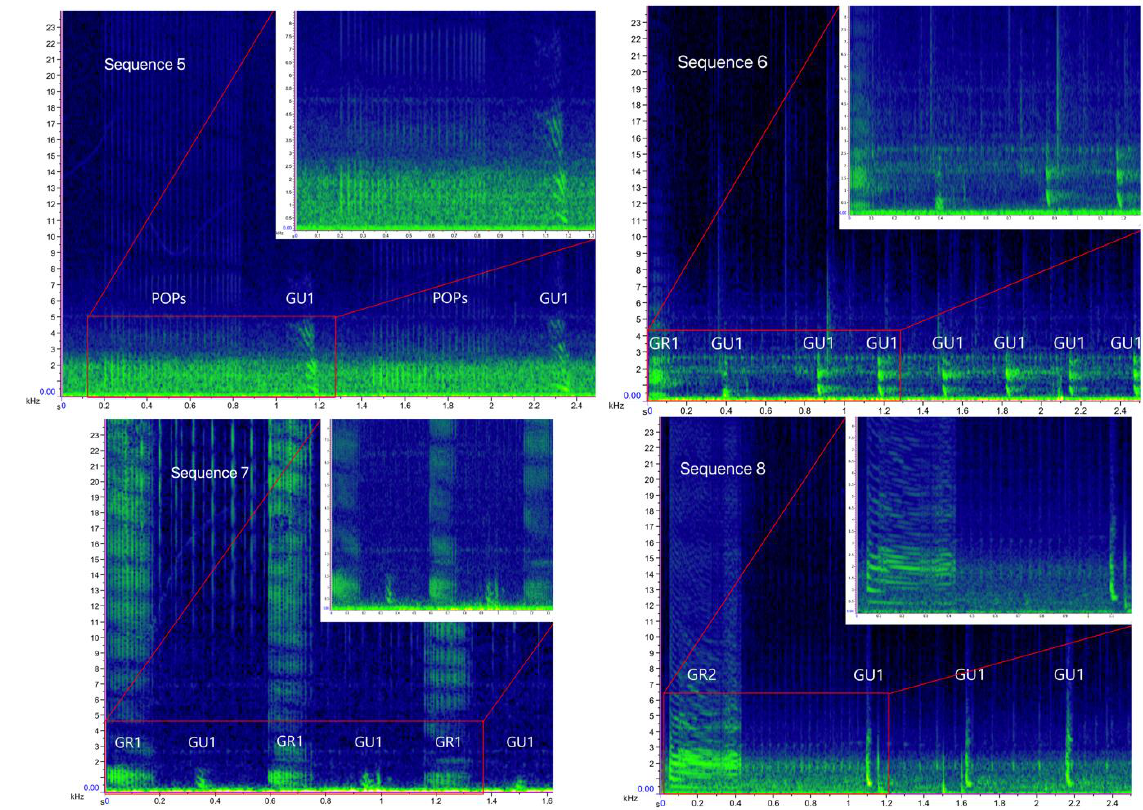
Figure 4. Spectrograms of the bray-call sequences 1–8 identified in the present study (main panels: Hann window, size 2048, DFT 2048, overlap 50%, hop size 1024, sampling frequency 192 kHz, frequency resolution 93.75 Hz, analysis bandwidth 135 Hz at -3 dB); zoomed panels: Hann window, size 3000, DFT 4096, overlap 80%, hop size 600, sampling frequency 192 kHz, frequency resolution 46.875 Hz, analysis bandwidth 92.16 Hz at -3 dB).